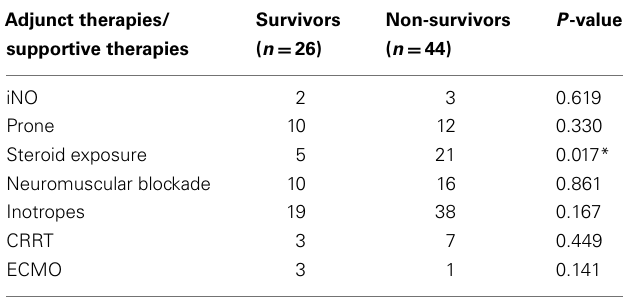
Table 3 | Use of adjunct therapies forARDS and other supportive therapies